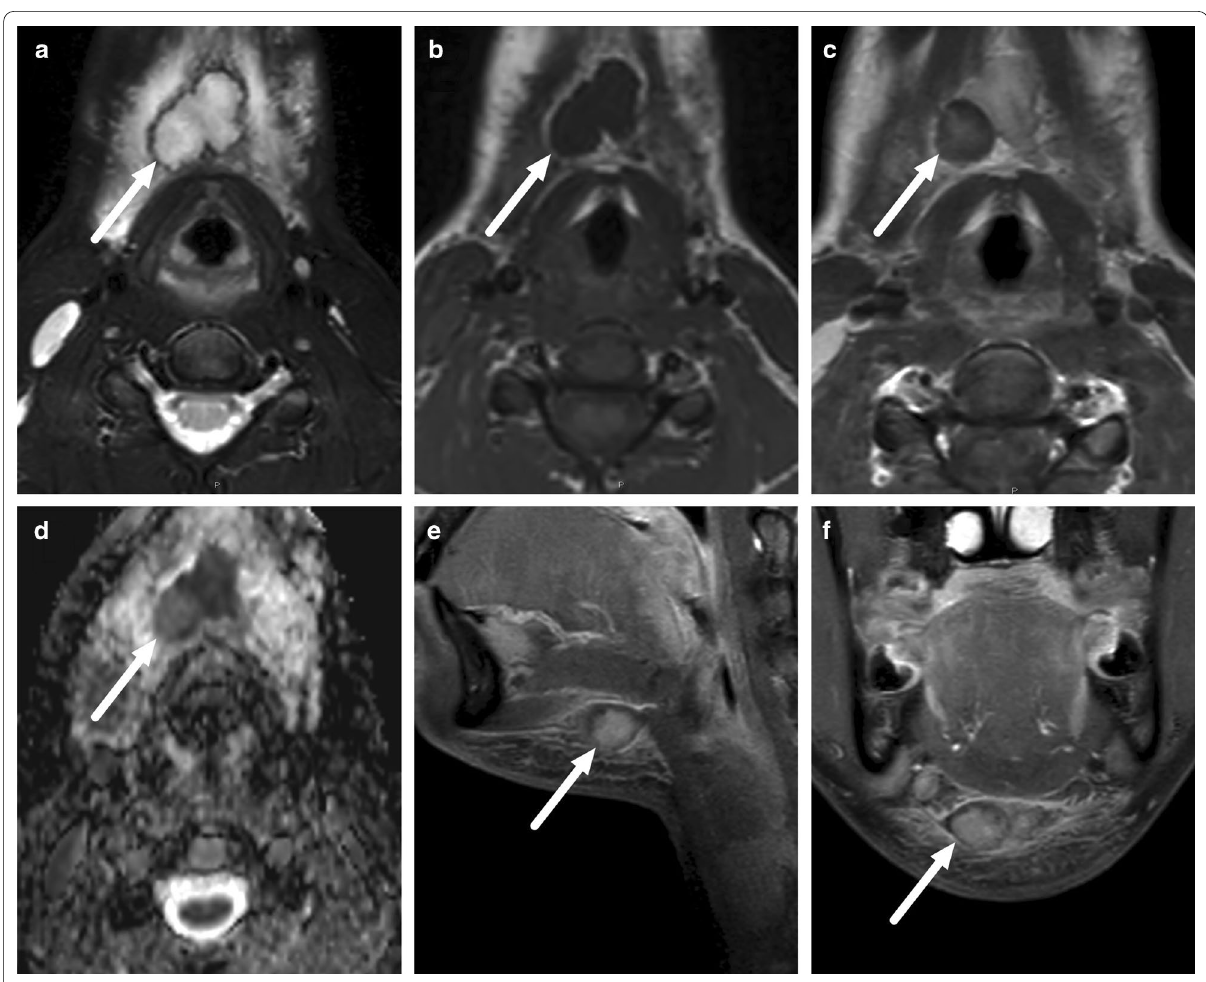
Fig. 34 Necrotic lymphadenitis (arrows) misdiagnosed as suppurative lymphadenitis in a teenager. Lymphadenitis is seen on the axial fat-suppressed T2-weighted image ( a ) and poor enhancement on the post-contrast T1-weighted image ( c ) compared with the pre-contrast image ( b ). ADC shows restricted diffusion ( d ). The finding was misinterpreted as suppurative lymphadenitis; however, at later time points, delayed enhancement is seen ( e , f ), ruling out suppuration. Surgery found necrosis, but no pus. Image modified from ref. [8]